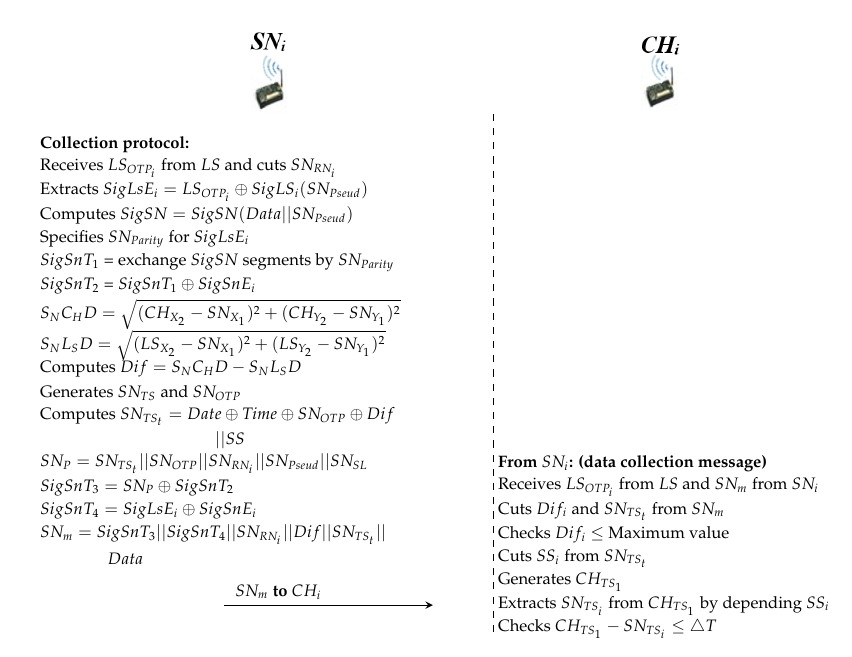
Figure 6. Data collection